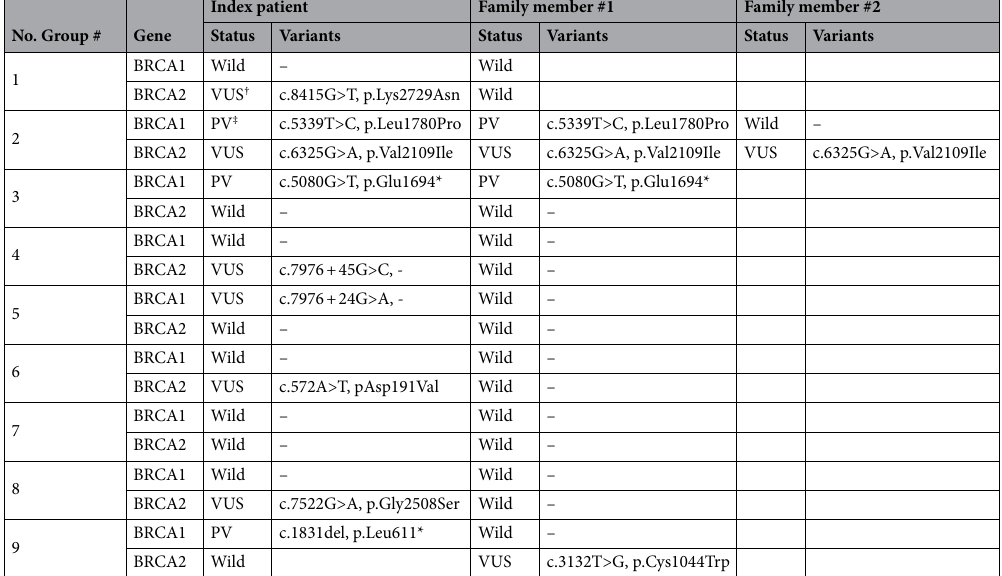
Table 2. Results of conventional cascade genetic testing for gBRCA1/2 status. † VUS variant of uncertain significance, ‡ PV pathogenic variant.